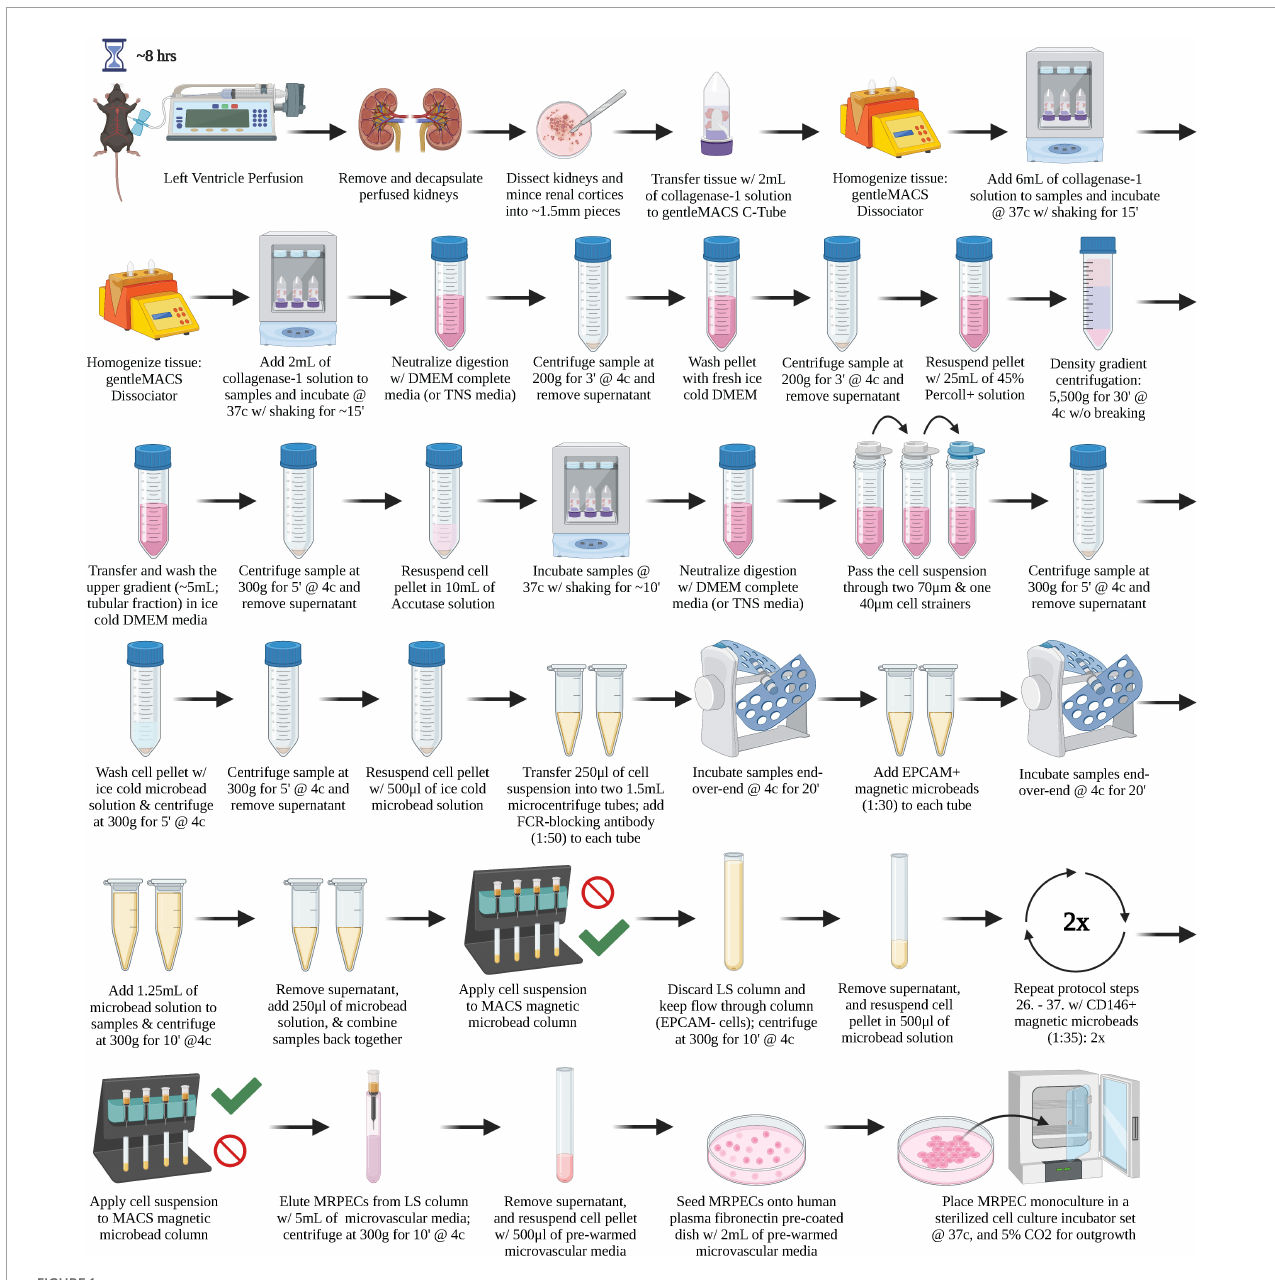
FIGURE1 A graphical overview of the step-by-step procedure for the isolation and monoculture of primary